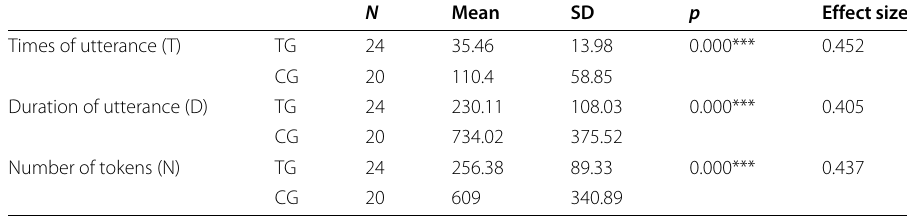
Table 6 Difference in engagement indicators for knowledge exchange phase